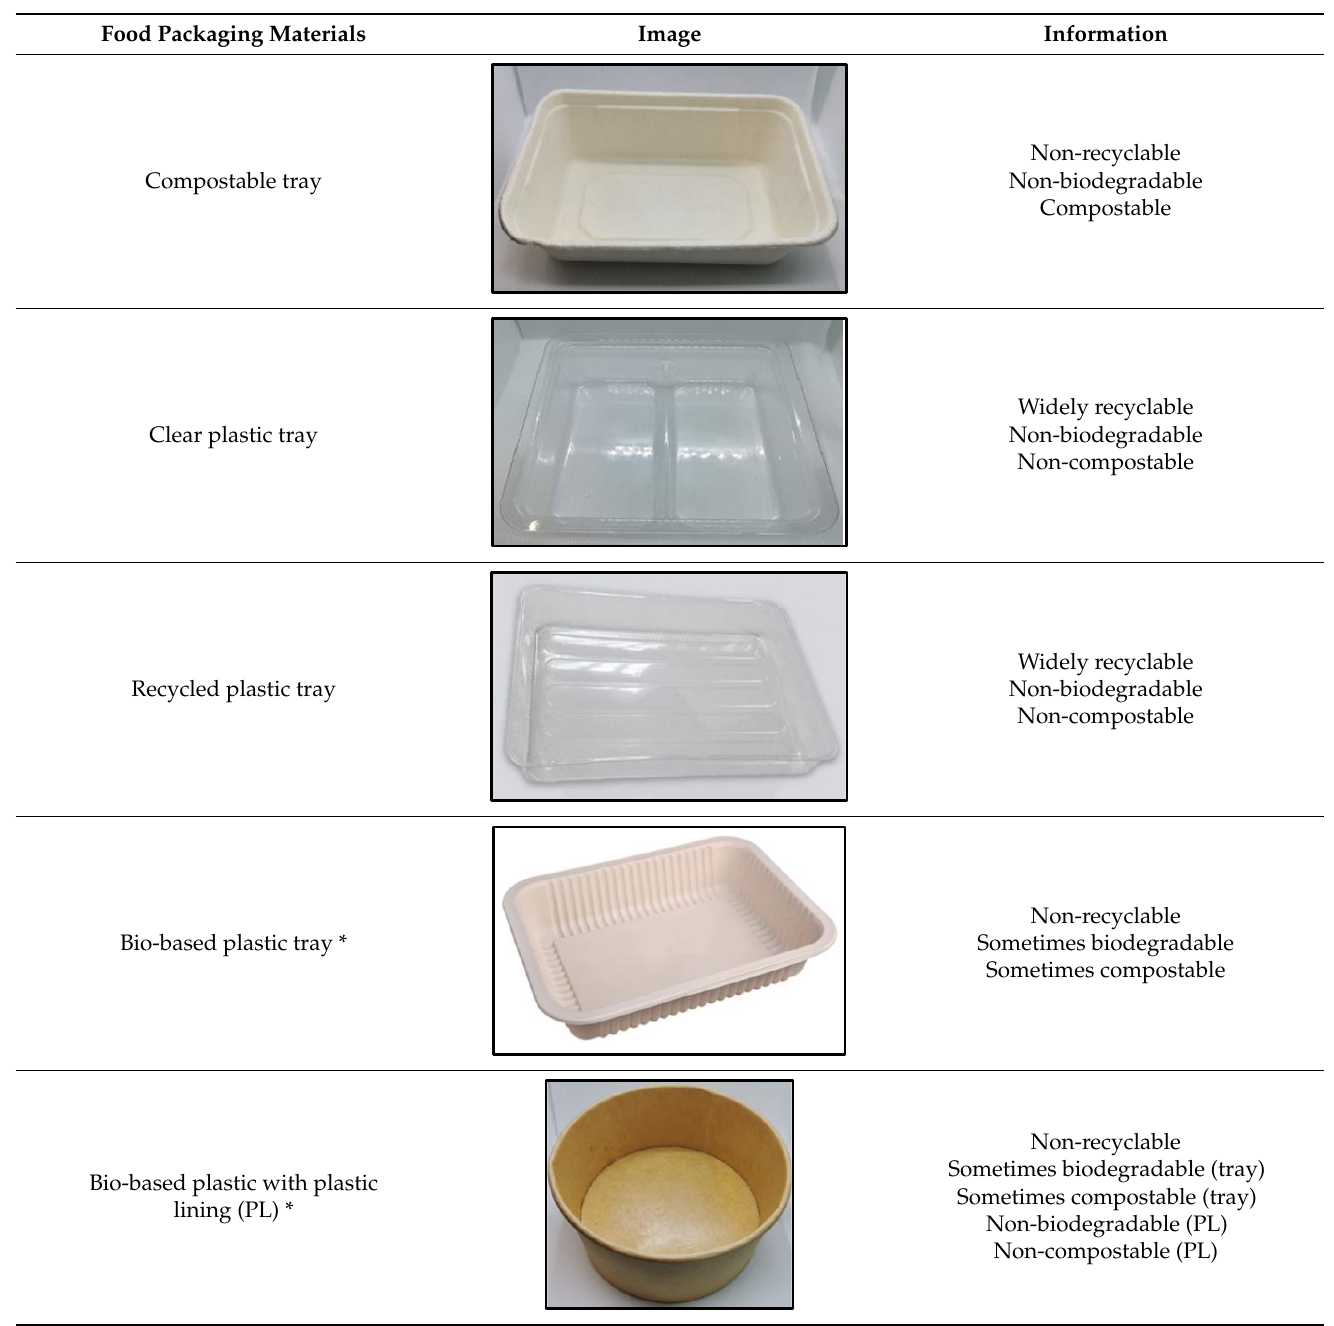
Figure 2. Summary of the two food packages. This question was asked twice: ( A ) with no information and ( B ) with added information, using a three-point category scale (option A, option B